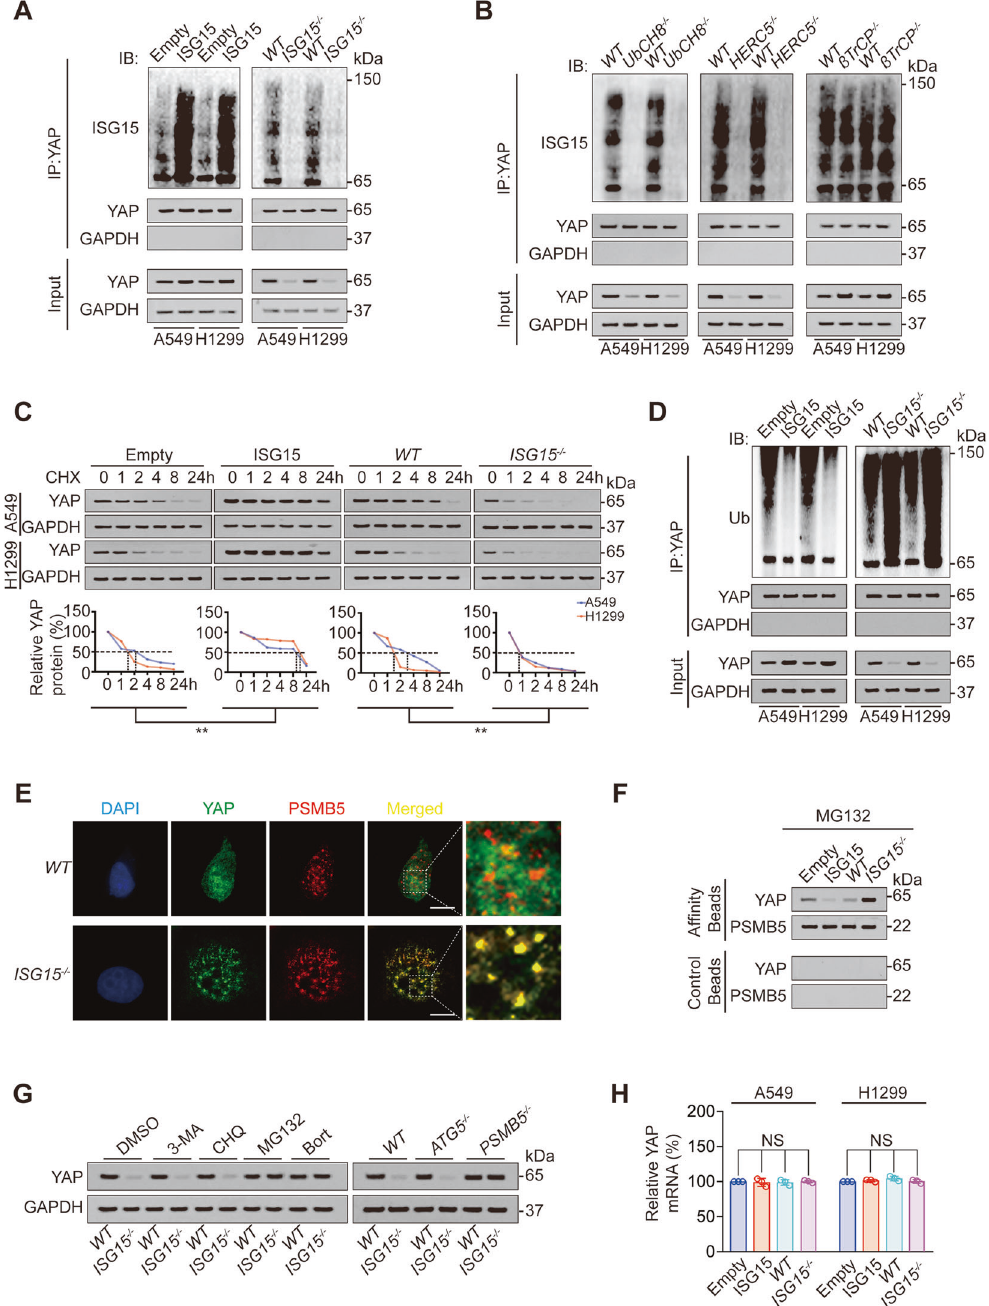
Fig. 1 YAP ISGylation inhibits its ubiquitination and increases its stability. A Co-IP was performed in control, ISG15 overexpression or knockout A549 and H1299 cells using anti-YAP antibodies. The YAP level in each co-IP sample was adjusted to the same protein content. Indicated proteins were further analyzed by IB. B Co-IP was performed in control or UbCH8, HERC5, or β TrCP knockout A549 and H1299 cells using anti-YAP antibodies. The YAP level in each co-IP sample was adjusted to the same protein content. Indicated proteins were further analyzed by IB. C CHX (10 μ g/ml) chase experiments were performed in control, ISG15 overexpression or knockout A549 and H1299 cells. The relative protein levels of YAP were shown as the ratios between YAP and GAPDH, and the “ 0 h ” points were arbitrarily set to 100%. D Co-IP was performed in control, ISG15 overexpression or knockout A549 and H1299 cells using anti-YAP antibodies. The YAP level in each co-IP sample was adjusted to the same protein content. Indicated proteins were further analyzed by IB. E Co-localization of YAP and PSMB5 was analyzed in WT or ISG15 − / − A549 cells before being photographed using a confocal microscope. Scale bar, 20 μ m. F Association of YAP and PSMB5 analyzed by IB in proteasomes isolated from A549 cells with or without ISG15 overexpression or knockout in the presence of MG132 (8 μ M, 24 h). Samples from af fi nity or control beads were analyzed in parallel. G YAP expression was analyzed by IB in WT or ISG15 − / − A549 cells with 3-MA, CHQ, MG132, or Bort treatment or with ATG5 or PSMB5 knockout. H YAP mRNA level was analyzed in control, ISG15 overexpression or knockout A549, and H1299 cells. The data are shown as the mean ± SD from three biological replicates (including IB). Data in C were analyzed using a two-way ANOVA test. Data in H were analyzed using a one-way ANOVA test. NS nonsigni fi cant.